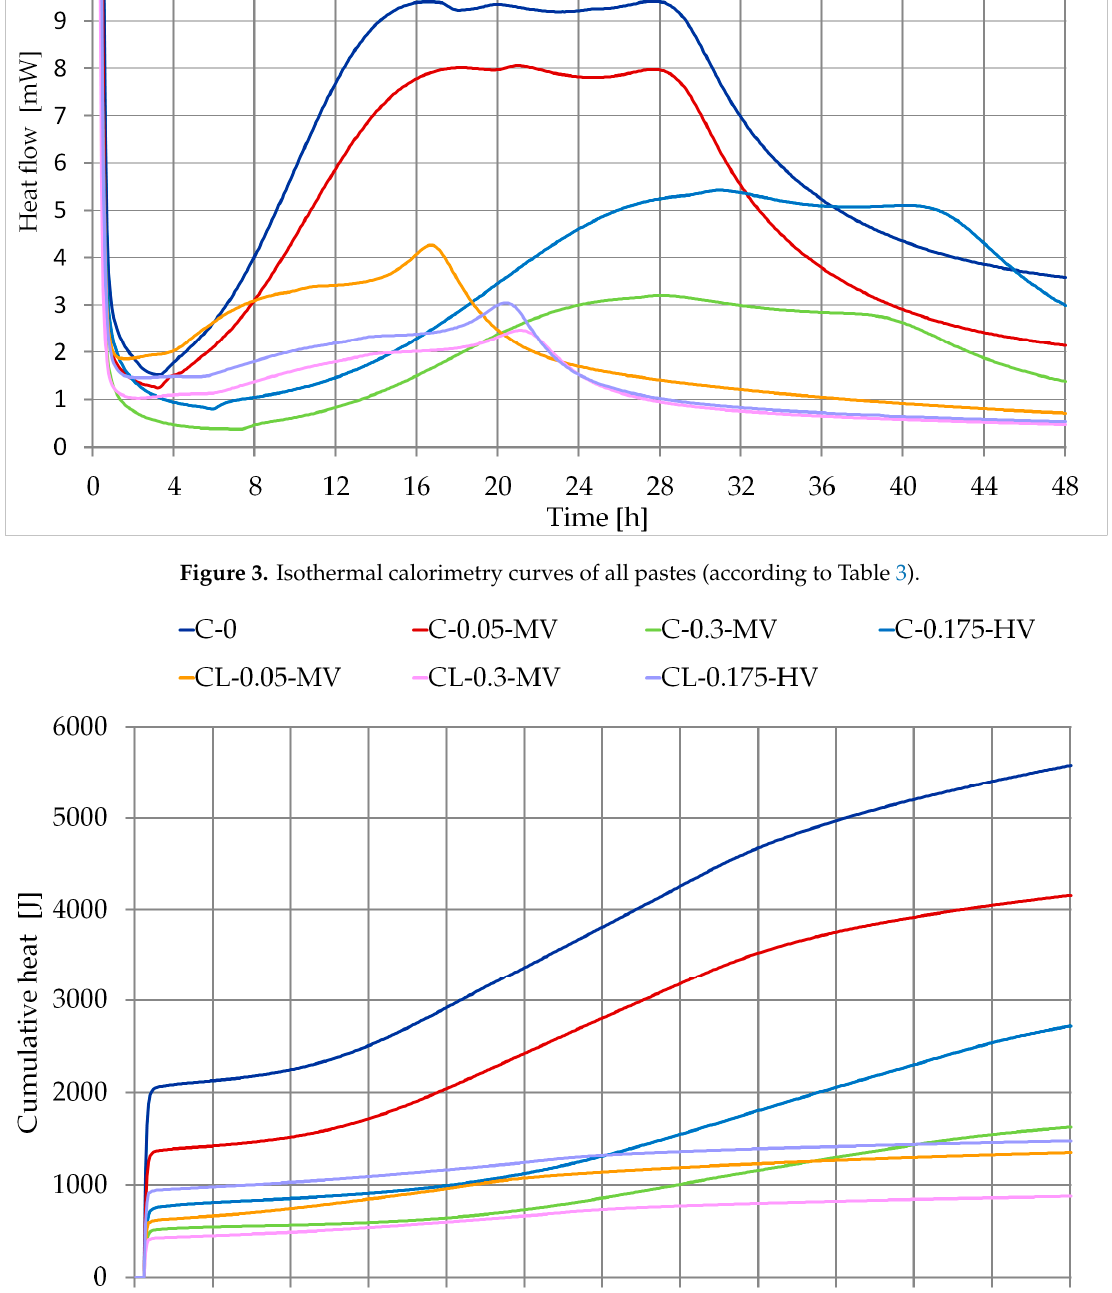
Table 5. Characteristic parameters of heat evolution curves for all pastes (Figures 3 and 4).